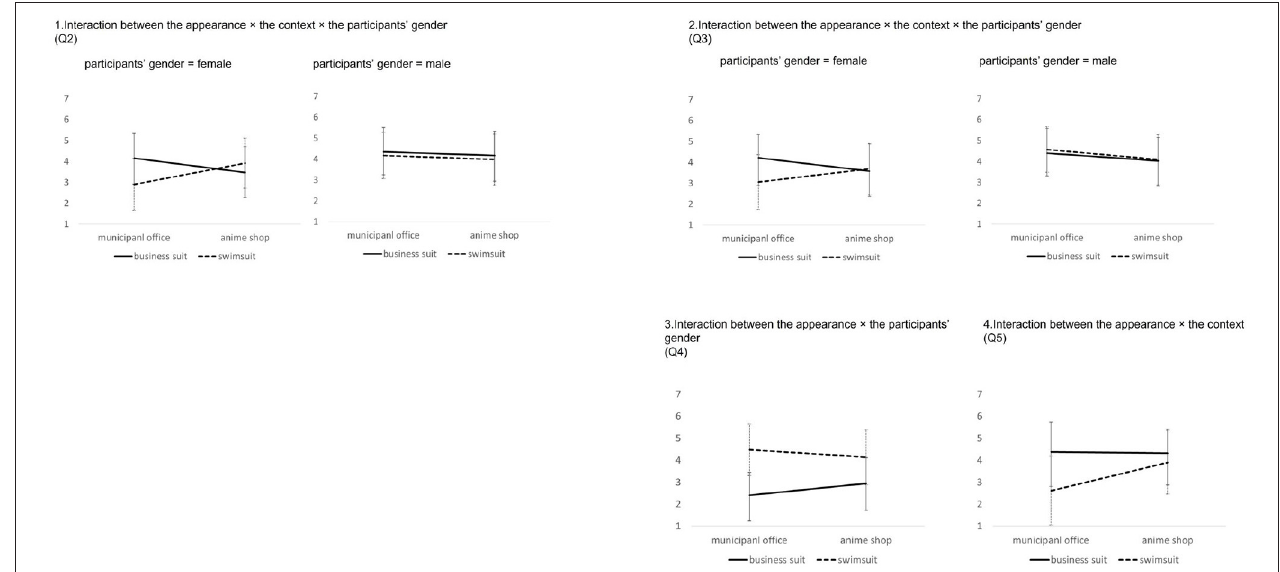
FIGURE 4 | Graphs showing interaction observed in the